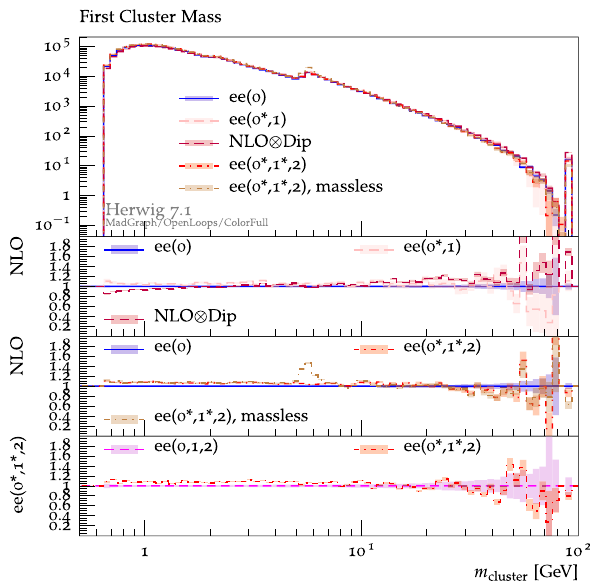
Fig. 8 As Fig. 7 the mass spectrum of primary formed clusters is shown. Here the NLO variants in multi jet merging and the MC@NLO like contribution are